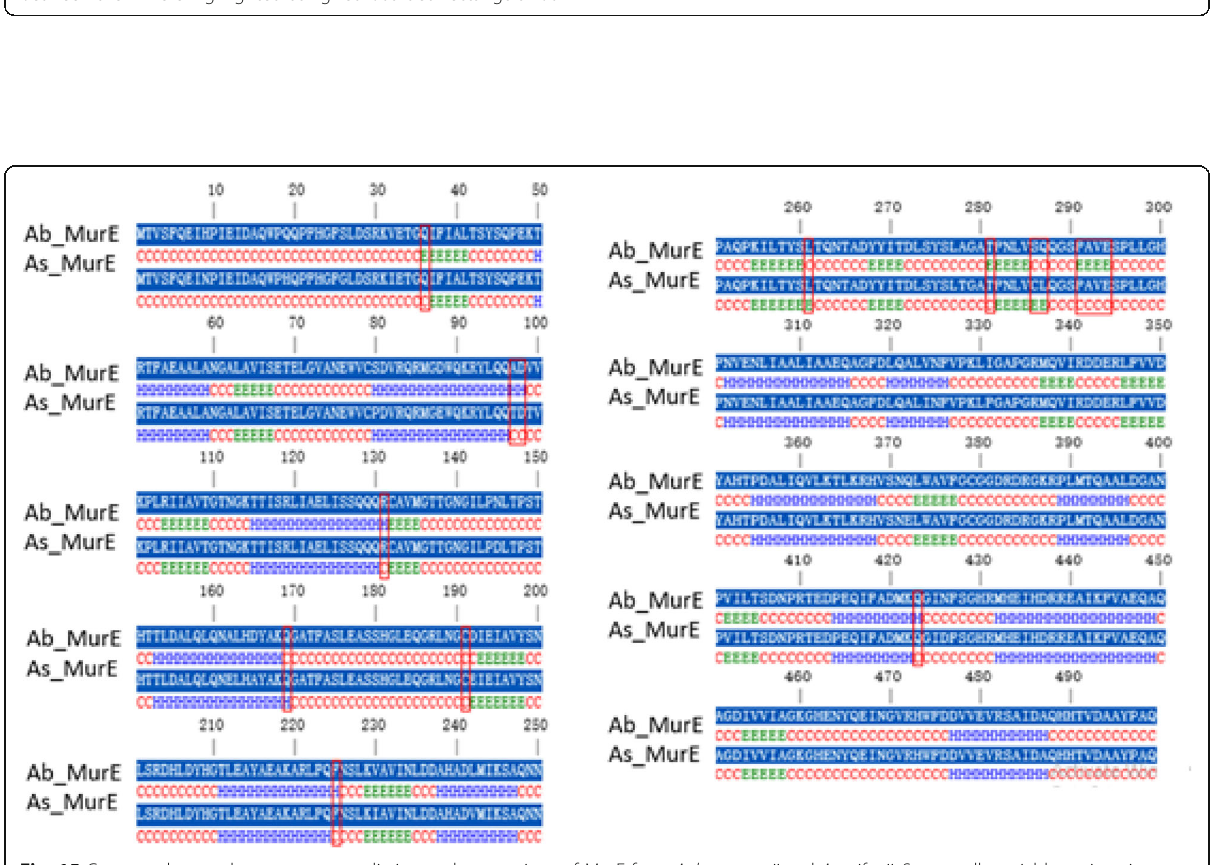
Fig. 15 Conserved secondary structure prediction and comparison of MurE from A . baumannii and A . seifertii. Structurally variable regions in between them were highlighted using red boarded rectangular box